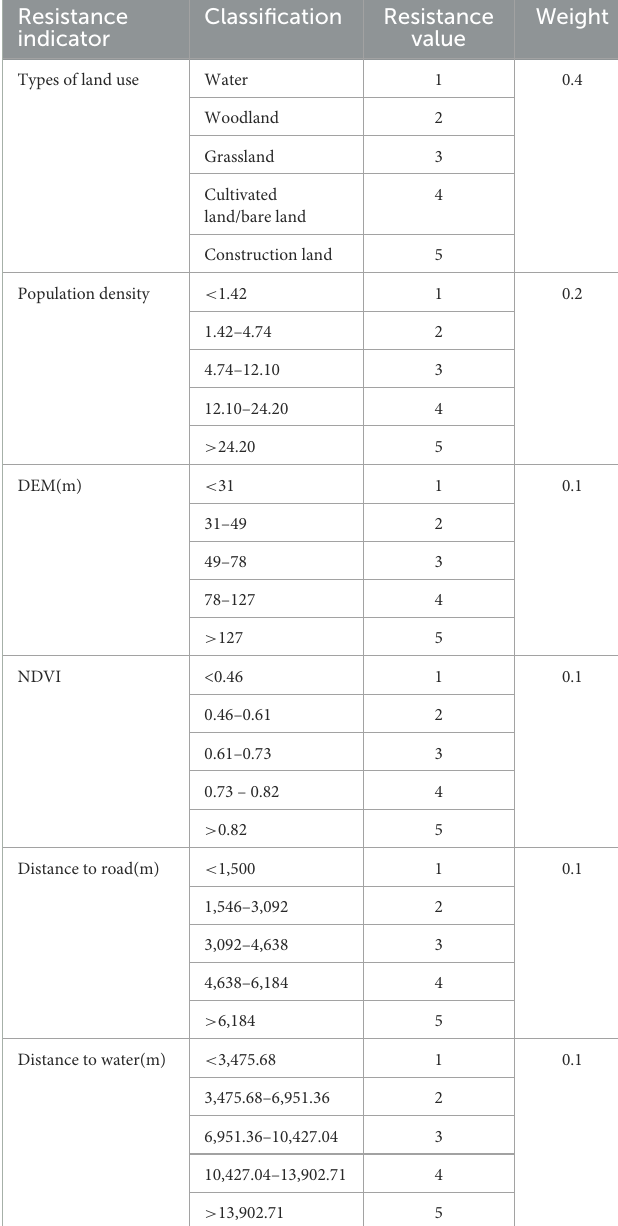
TABLE 2 Resistance factor and its resistance